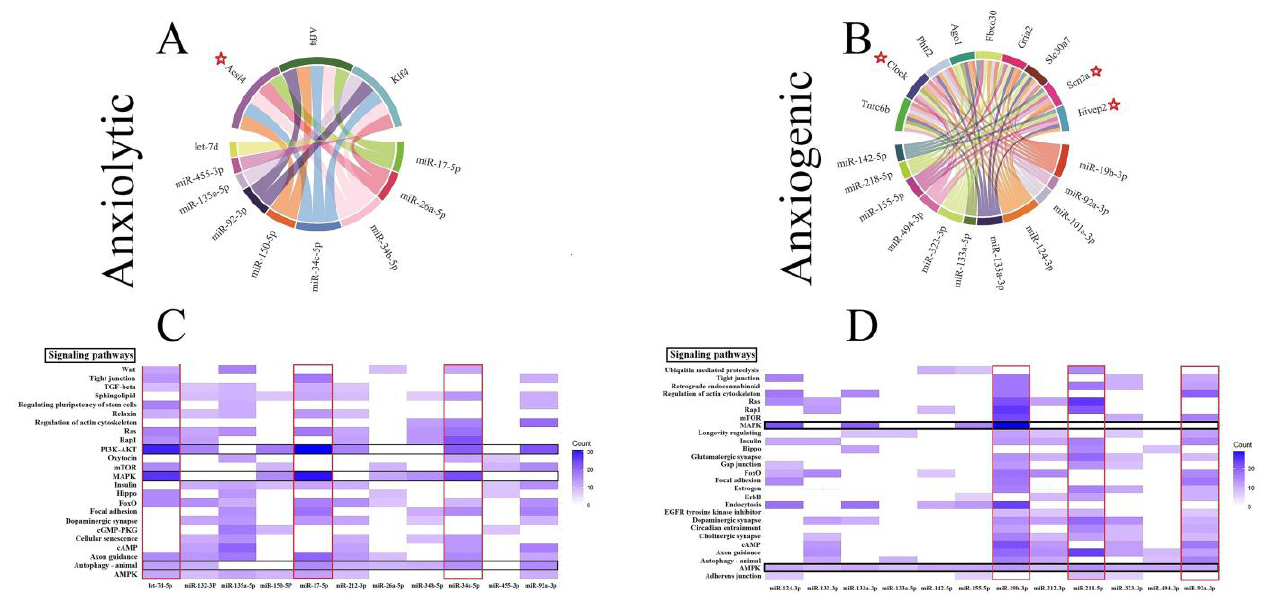
Figure 2. Common gene targets of ARmiRs and their signaling pathways. ( A ) The anxiolytic miRNAs mainly target three genes, including Acs14, Aff4, and K1f4. ( B ) There are nine common gene targets for anxiogenic miRNAs, and the highest interactions were by Tnrc6b (8 interactions). ( C ) Anxiolytic miRNAs cellular pathways. MAPK and PI3K-Akt are the most common target cellular pathways for anxiolytic miRNAs. The color intensity and scale introduce the number of genes each miRNA targets and participates in each cellular pathway. ( D ) Anxiogenic miRNAs cellular pathways. AMPK and endocytosis are the main target cellular pathways for the anxiogenic miRNAs. The color intensity and scale introduce the number of genes each miRNA targets and participates in each cellular pathway. Red Stars indicated genes with maximum interaction with miRNAs.